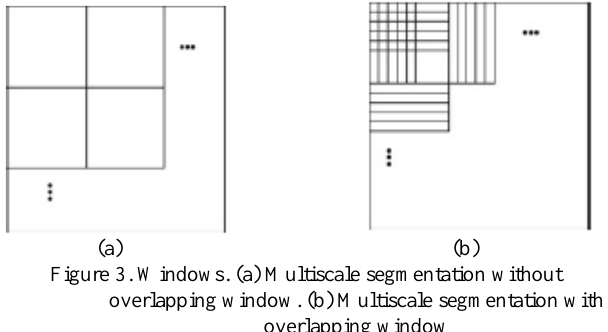
Figure 3. Windows. (a) Multiscale segmentation without overlapping window. (b) Multiscale segmentation with overlapping window